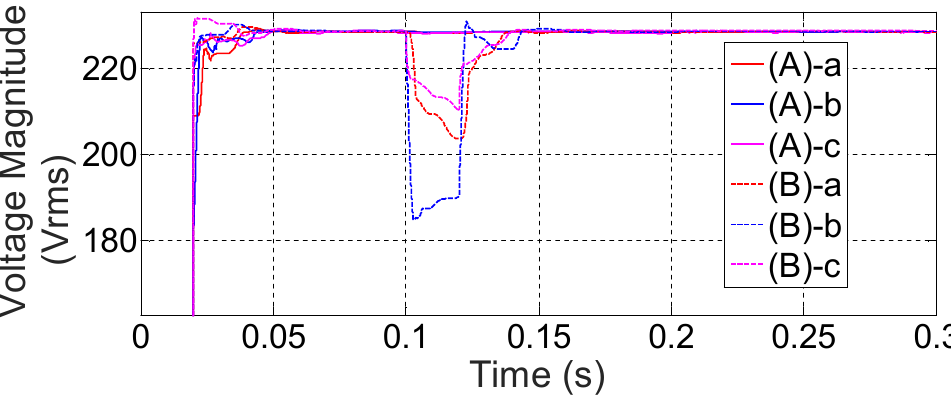
Figure 8. Voltage Magnitude per phase and microgrid in mode non-interconnected and